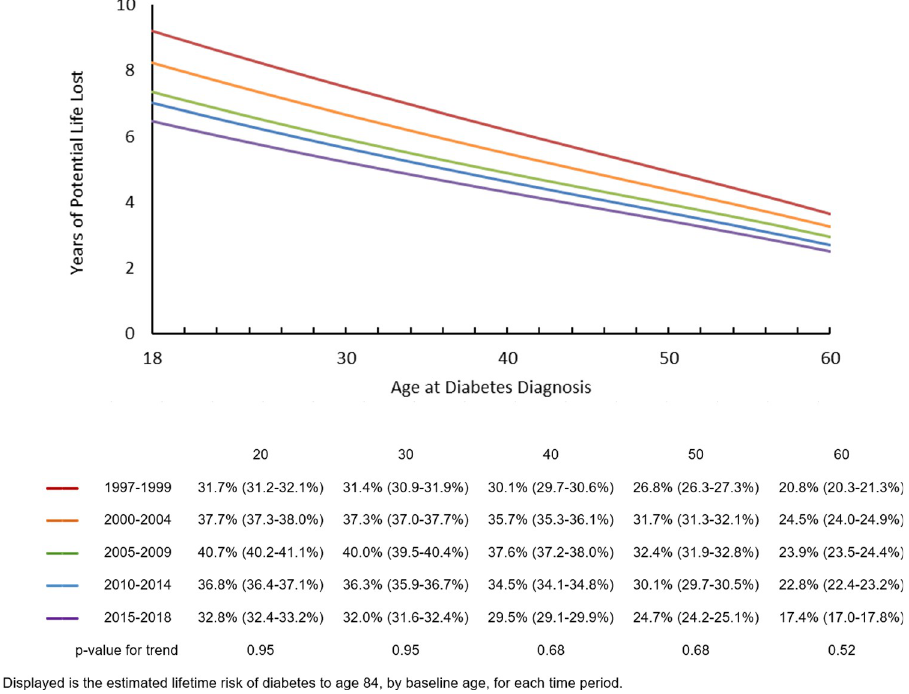
Fig 2. Years of potential life lost to age 84, by age at diabetes diagnosis and time period.